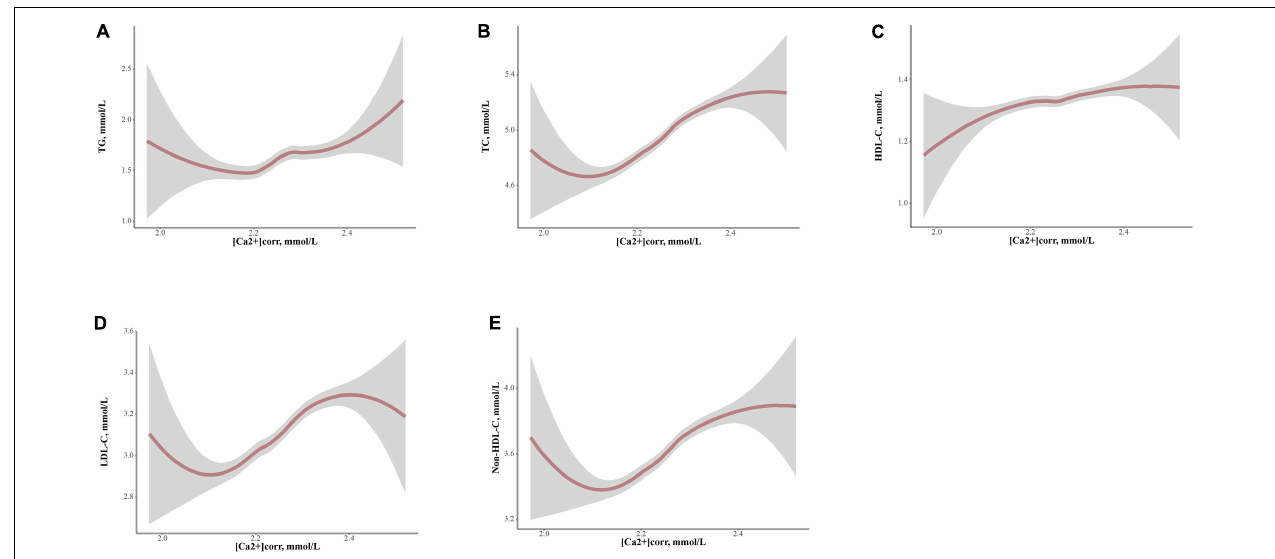
FIGURE 4 | Locally weighted regression (Loess) analyses of [Ca2+]corr on serum lipid parameter levels in graphs of smoothed values with confidence bands. (A) TG, (B) TC, (C) HDL-C, (D) LDL-C, and (E) Non-HDL-C. [Ca2+]corr, corrected serum ionized calcium; TC, total cholesterol; TG, triglyceride; HDL-C, high-density lipoprotein cholesterol; LDL-C, low-density lipoprotein cholesterol; Non-HDL-C, non-high-density lipoprotein